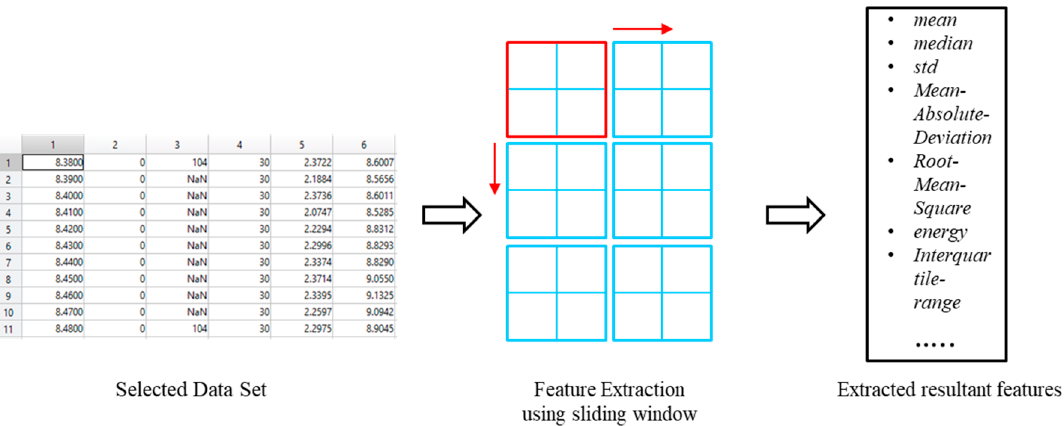
Figure 4. Feature extraction process.